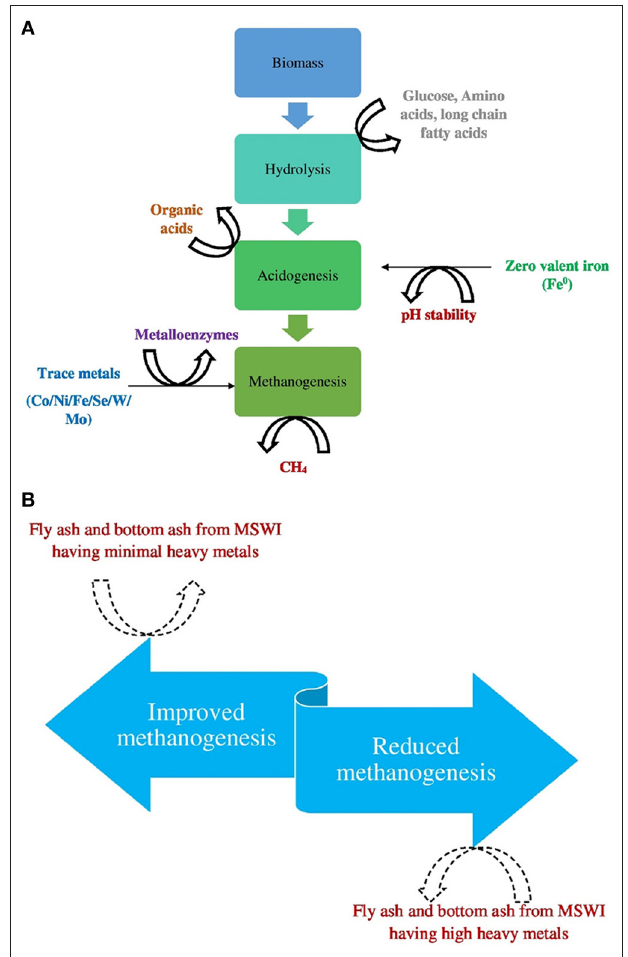
FIGURE 2 | (A) Mechanism of metal-based additives in anaerobic digestion. (B) Municipal solid waste incineration ash as additive in anaerobic